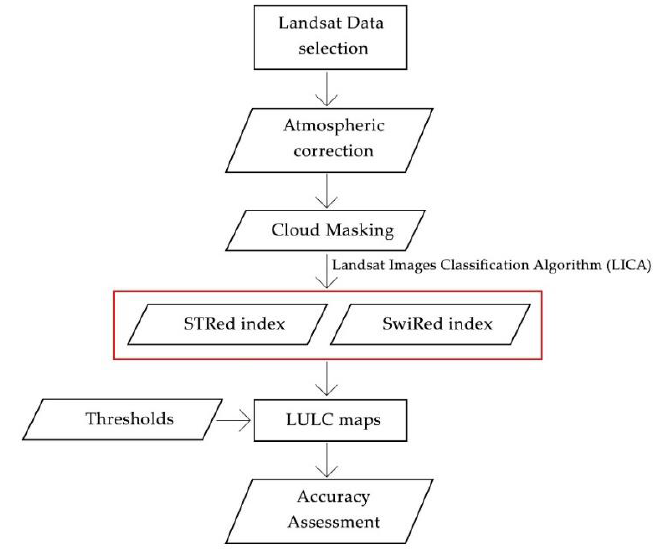
Figure 3. Landsat Images Classification Algorithm (LICA) classification